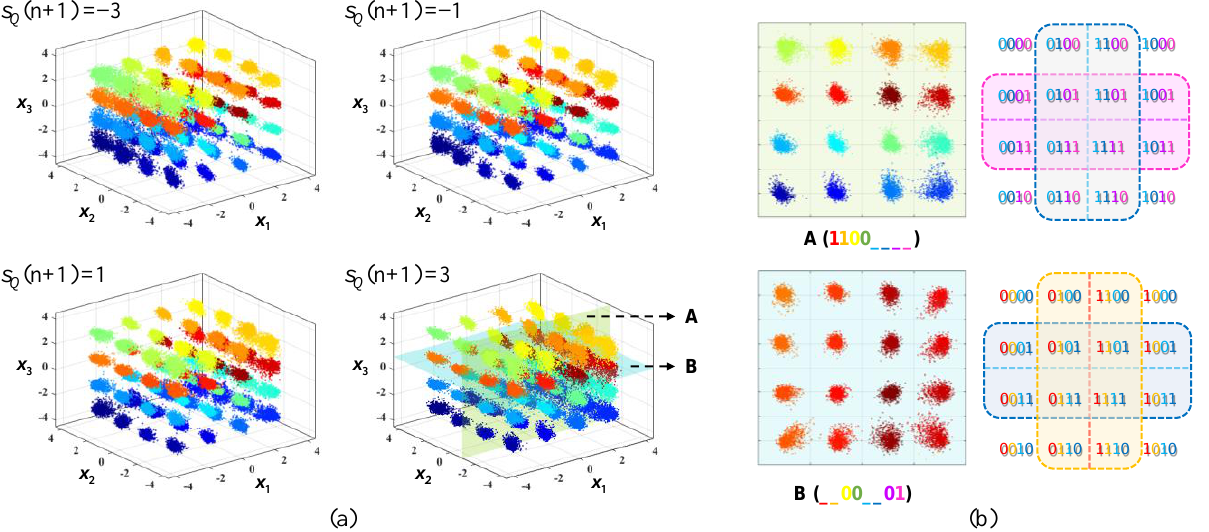
Figure 1. ( a ) Constellation diagrams of two consecutive symbols in simulated limited nonlinear channel. ( b ) Bit-based binary multi-class SVM strategy.